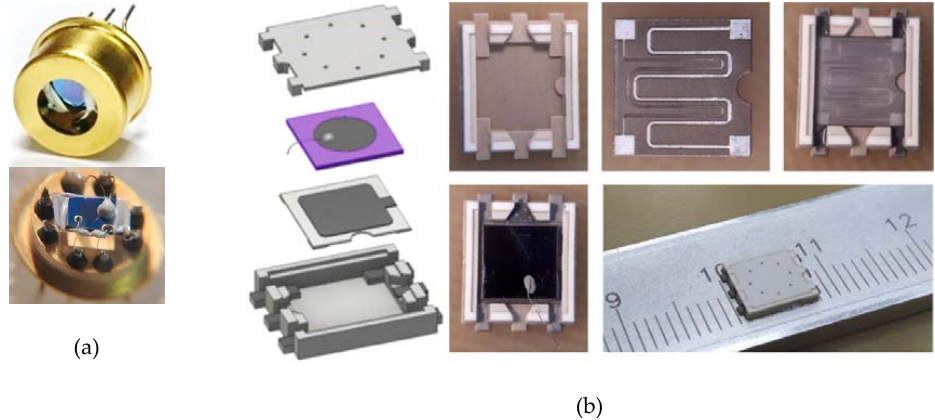
Figure 10. Scheme of the device MIS sensor in a typical sensor housing ( a ). An electronic model of the MIS sensor design components in a package of monolithic ceramics fabricated by the developed flexible laser micromilling technology ( b